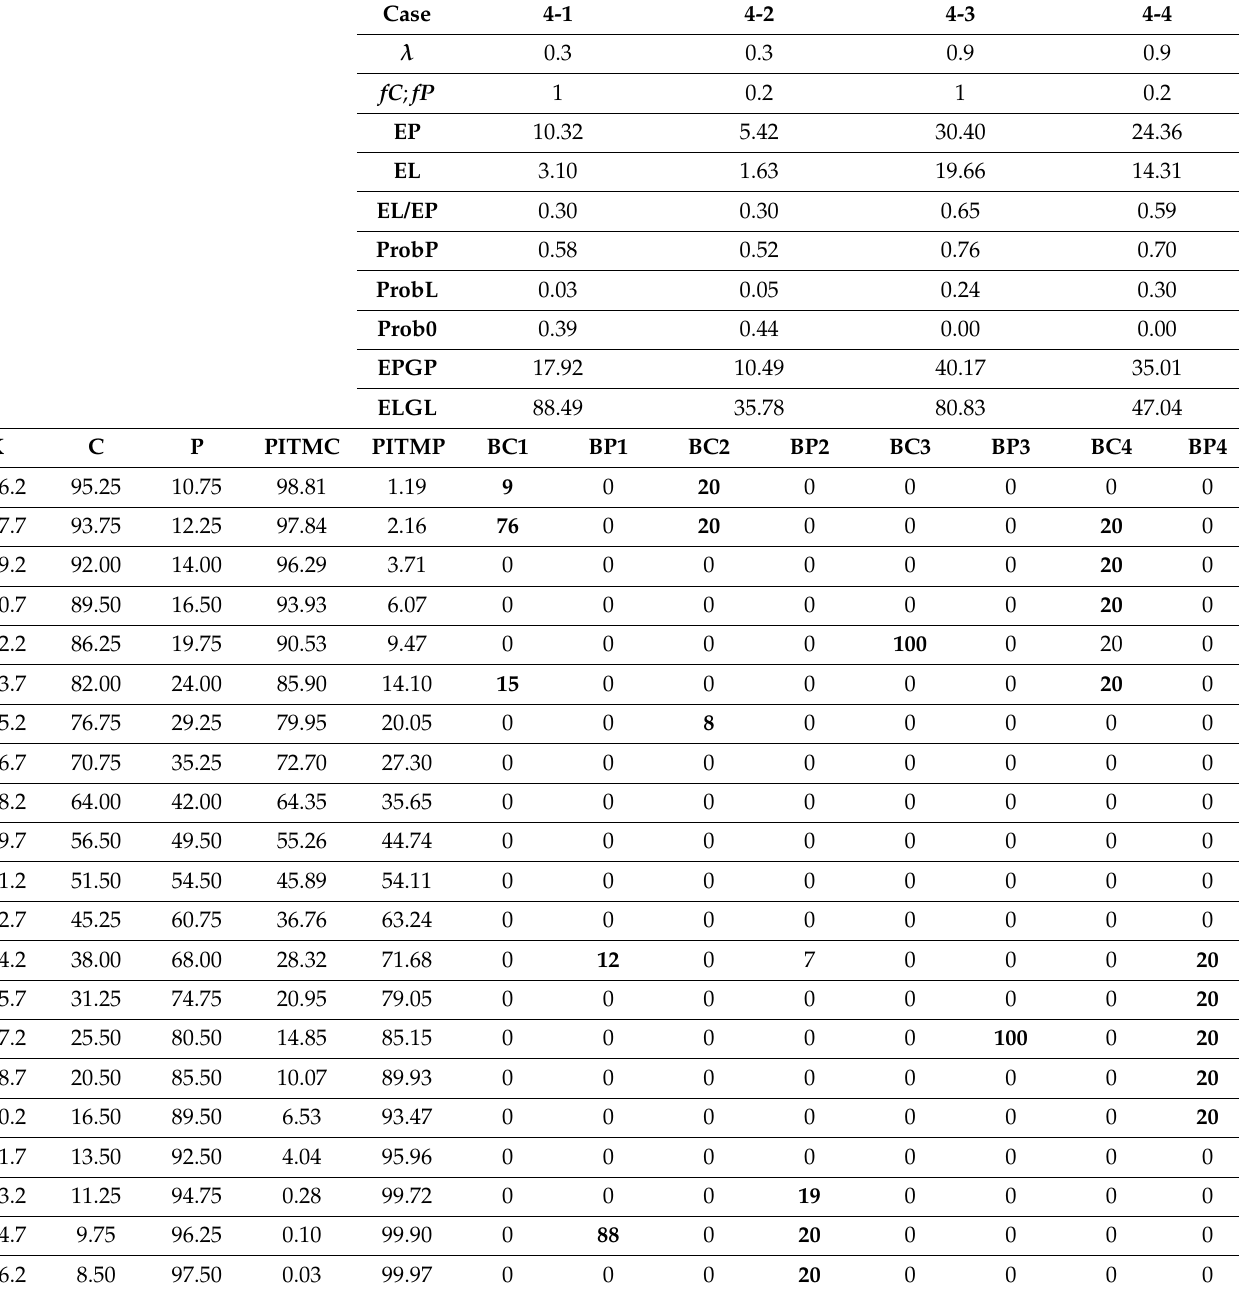
Table 5. Binary EPEL portfolio allocations and features for Case 4 with µ = − 0.0008, σ = 0.0035 and S 0 = 1822 in the GBM models and with varying γ and f C , f P applied to the Nadex gold binary